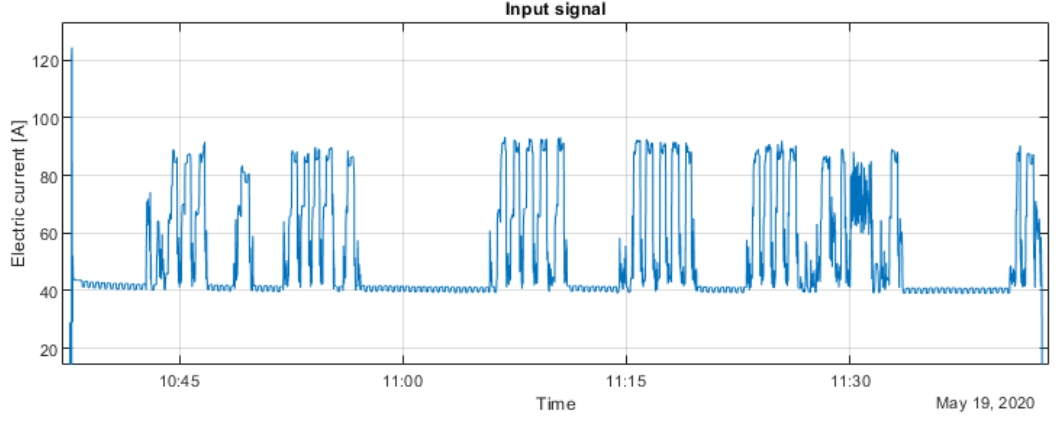
Figure 7. Input current signal.